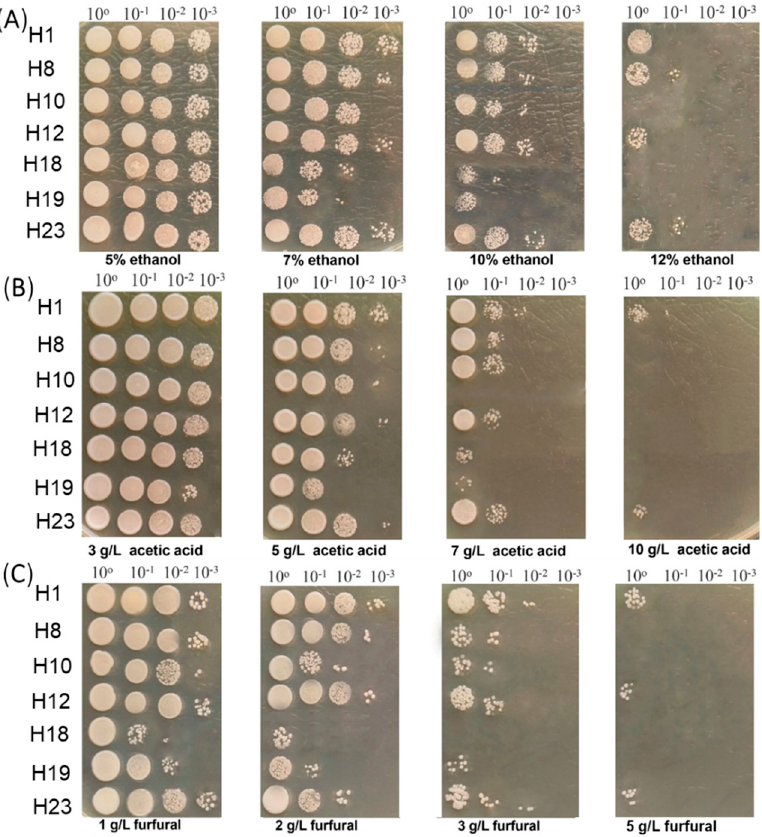
Figure 2. Yeast growth under different stresses. Serial 10-fold dilutions of different isolates were spotted onto YMA plates supplemented with different stress concentrations of ethanol ( A ), acetic acid ( B ) and furfural ( C ). All tests were incubated at 37 °C for 48 h.